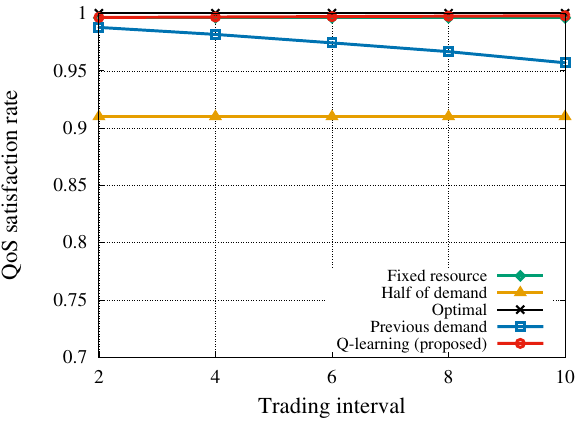
Figure 6. QoS satisfaction rate with respect to the trading interval.